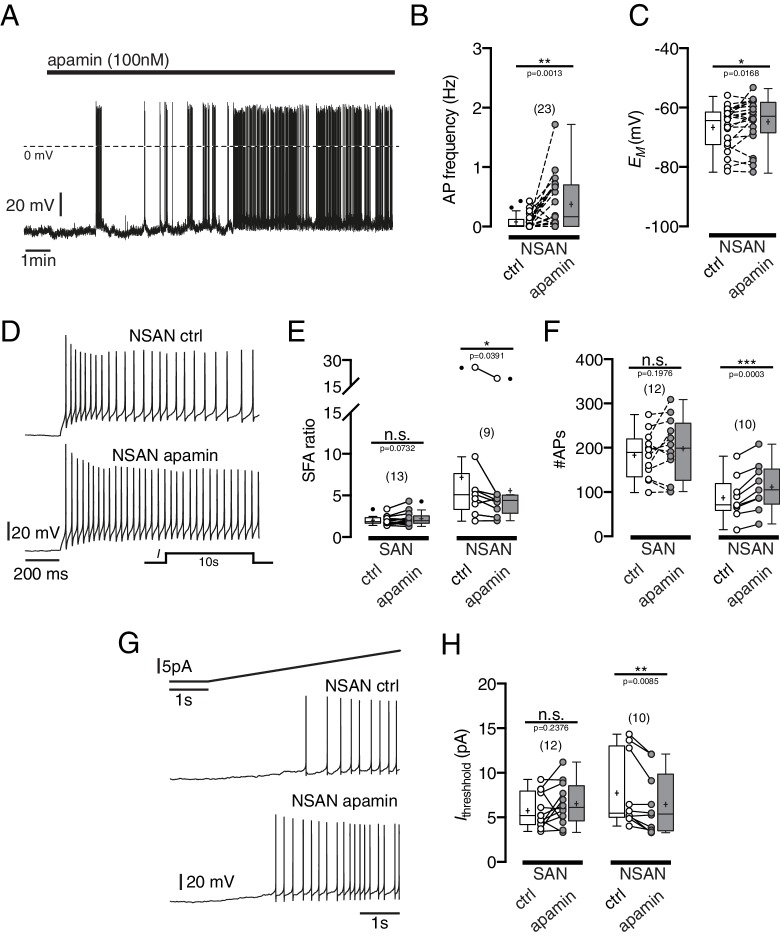
Blocking SK currents by apamin changes intrinsic electrophysiological properties of silent POMC neurons.(A, B, C) The SK channel blocker apamin (100 nM) induced depolarization and action potential firing. (A) A silent POMC neuron depolarized and started to generate action potentials under apamin. Action potential frequency (B) and membrane potential (C) before and during apamin application. (D, E, F) Apamin decreased spike frequency adaptation in silent neurons. (D) Original recording of a silent POMC neuron. Apamin reduced the SFA ratio (E) and increased the number of action potentials (F) during depolarization in silent but not in spontaneously active neurons. (G, H) Apamin reduced Ithreshold only in silent POMC neurons. (G) Recording of a silent POMC neuron. (H) Quantification of the apamin effect on Ithreshold. SAN, spontaneously active neuron; NSAN, not spontaneously active neuron (F < 0.5 Hz). Paired t-test. *p<0.05, **p<0.01, ***p<0.001.